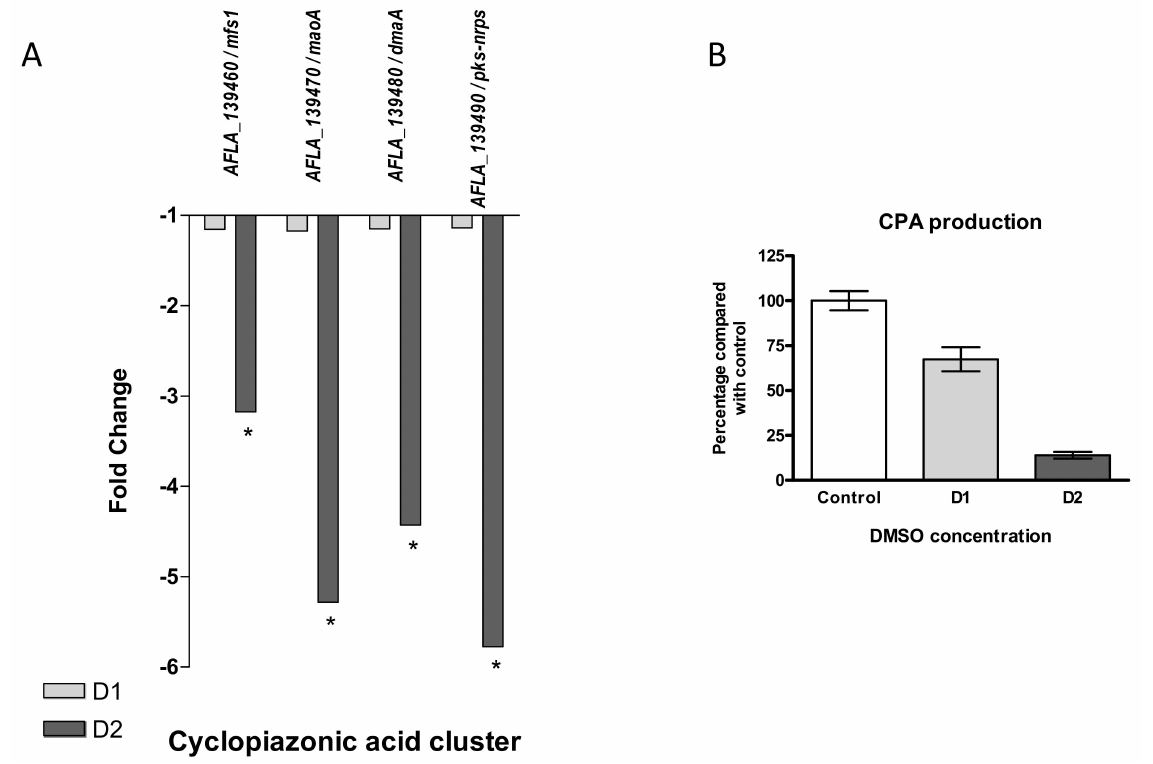
Figure 9. Effect of DMSO treatment on cyclopiazonic acid biosynthesis pathway. ( A ) Fold change expression of genes belonging to the cyclopiazonic acid cluster (#55) in response to DMSO (D1 and D2); * q -value < 0.05. ( B ) Impact of DMSO on CPA production of Aspergillus flavus NRRL 62477 after 4 days at 27 ◦ C. Results are expressed as percentage of the control value (+/ −